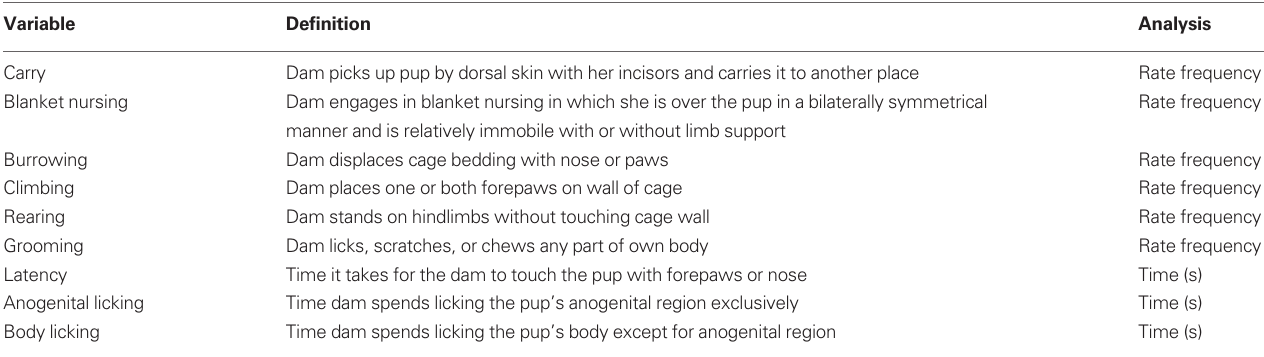
sessions conducted on PN4, PN7, and